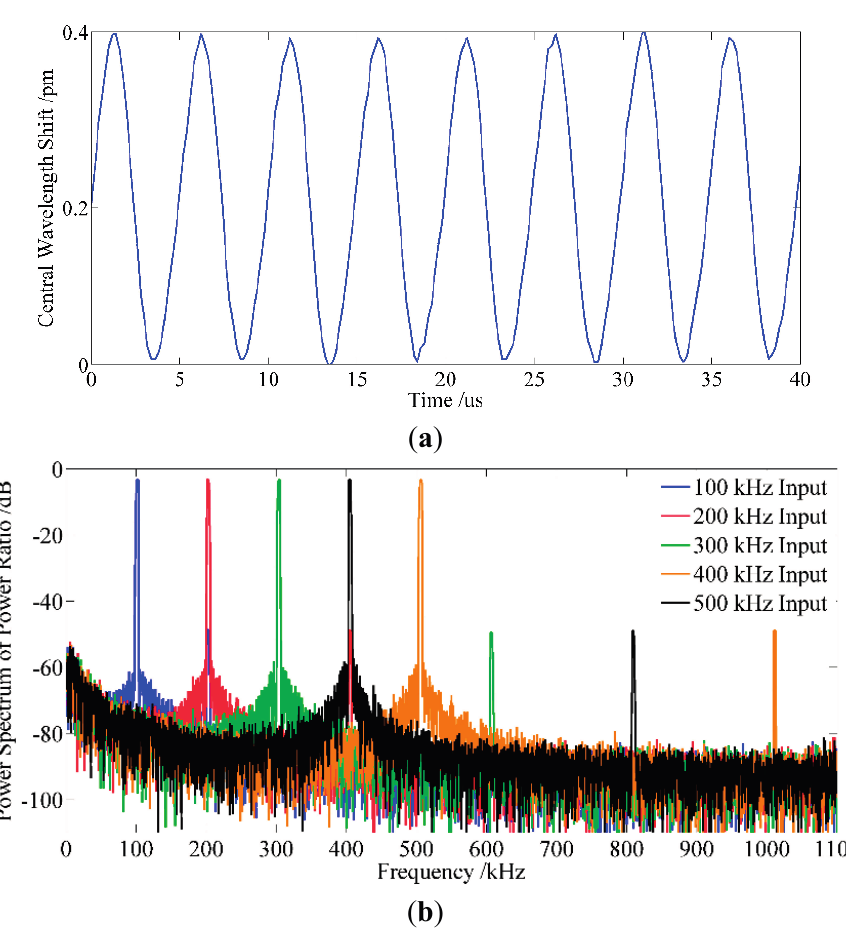
Figure 15. Experimental result of the frequency response: ( a ) temporal response resolution at 200 kHz; ( b ) high frequency responses at different